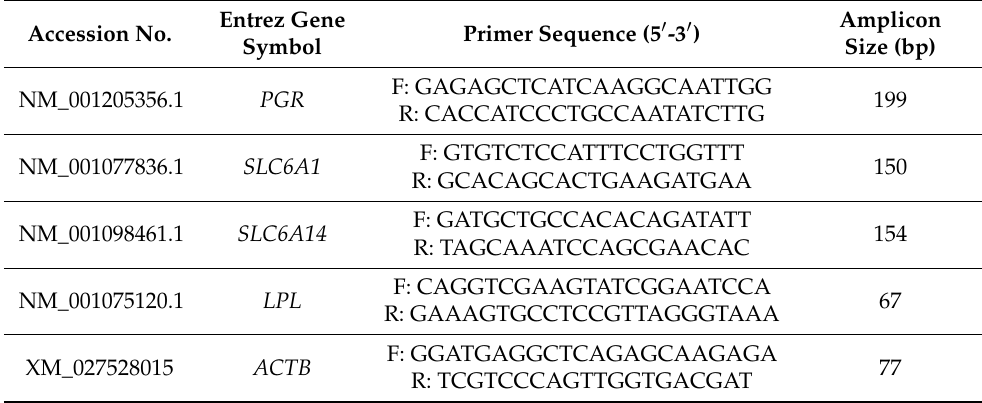
Table 1. Gene accession number, Entrez gene symbol, primer sequences (F: forward, R: reverse), and amplicon size for all genes used for